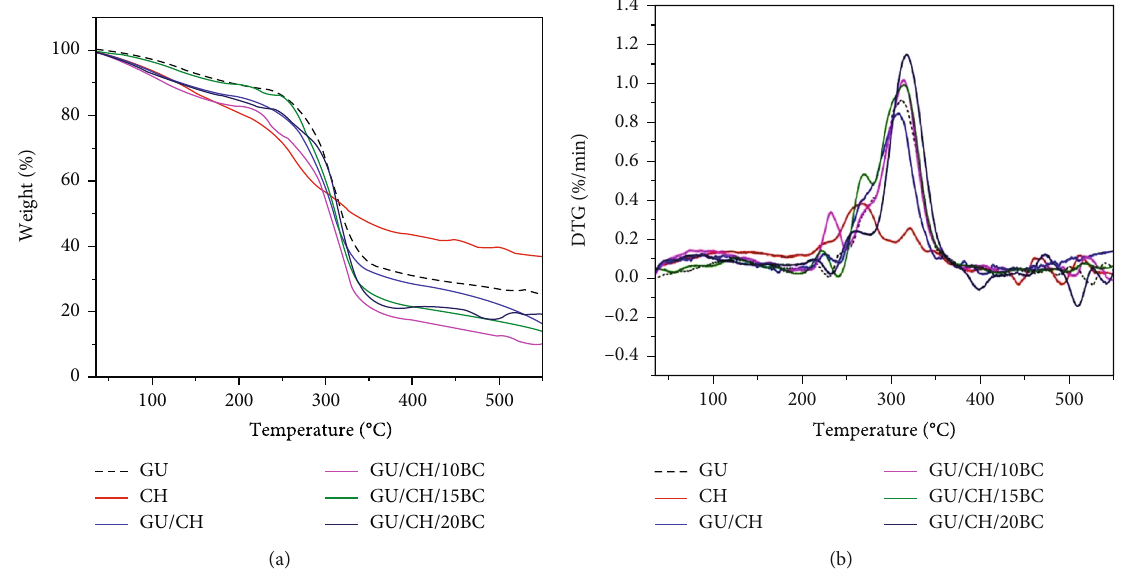
Figure 7: TGA (a) and DTG (b) charts of all